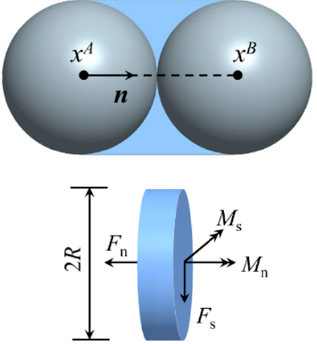
Figure 1. Parallel bond model of sea ice.